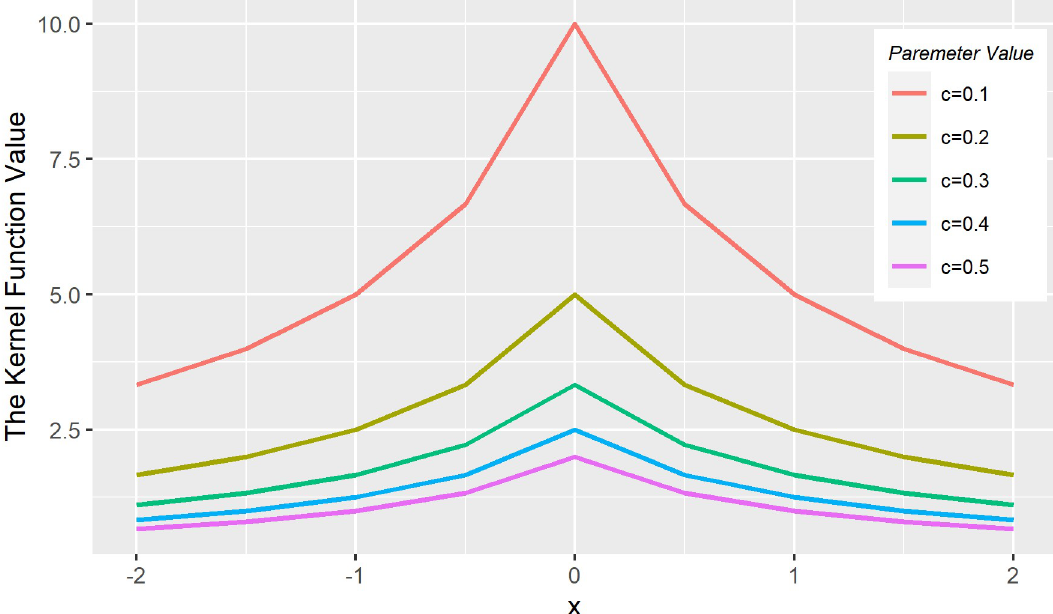
Fig 1. Multi-scale t kernel function under different